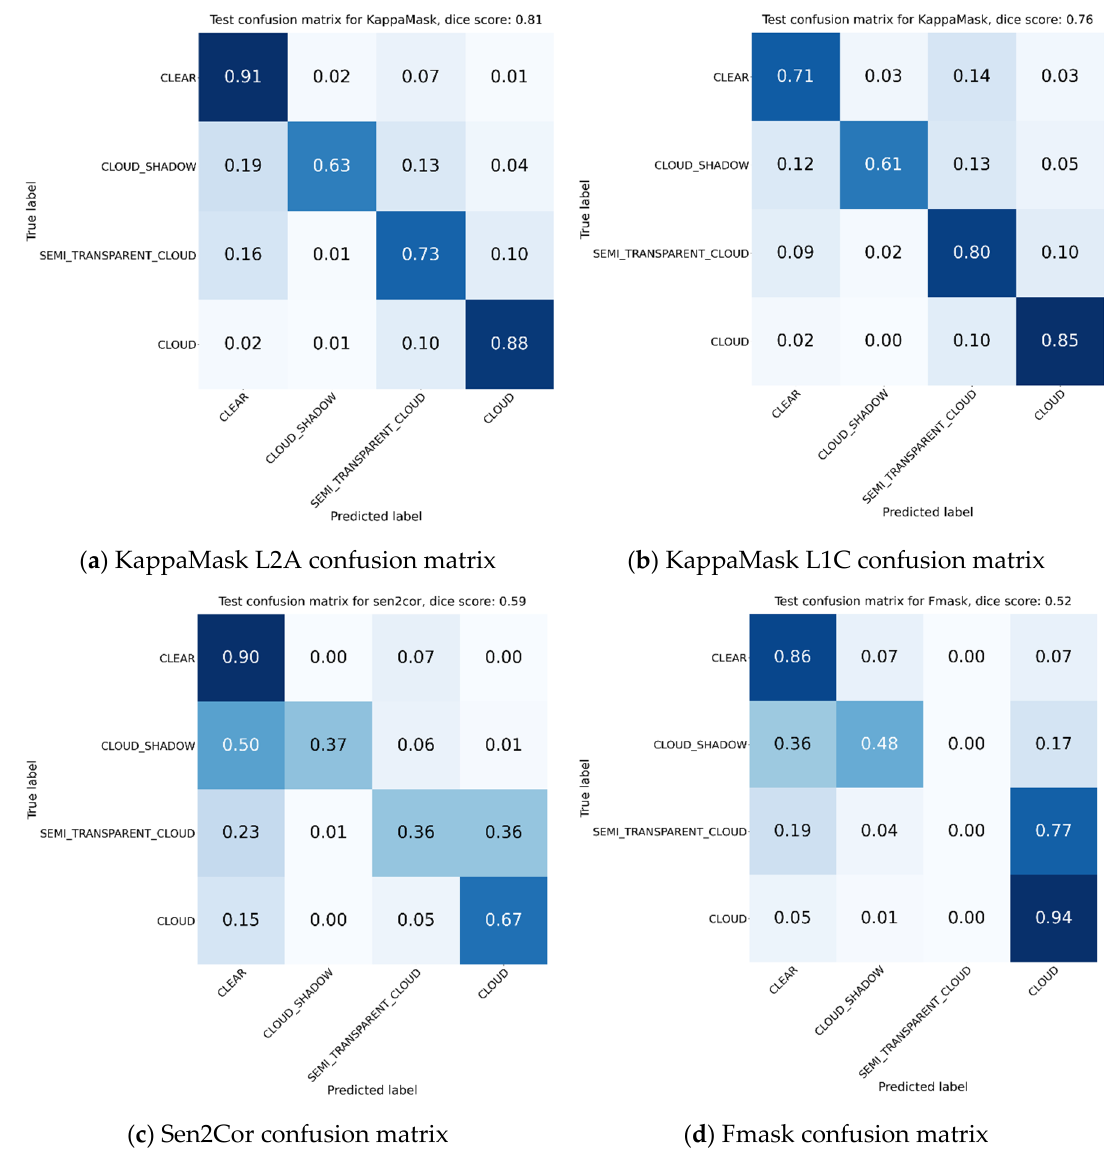
Figure 8. Confusion matrices on test set for ( a ) KappaMask Level-2A; ( b ) KappaMask Level-1C; ( c ) Sen2Cor; ( d ) Fmask. Confusion matrix consists of clear, cloud shadow, semi-transparent cloud, cloud and missing class; however, the last one is removed from this comparison to make matrices easier to